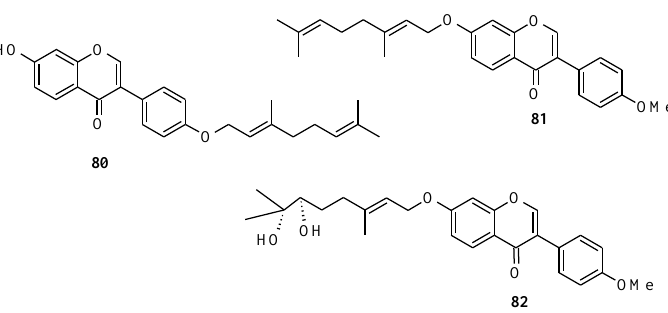
Figure 7. Structures of geranylated